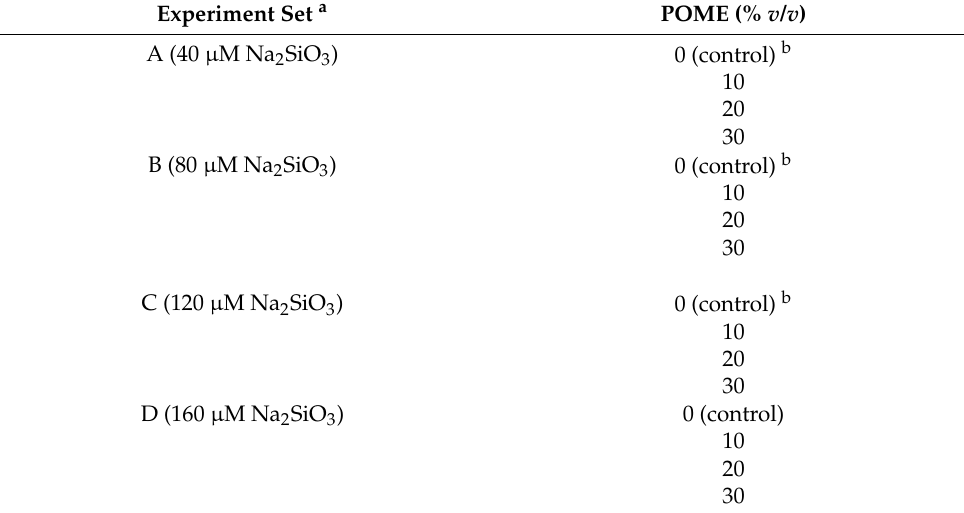
Table 2. Compositions of the media. Experiment Set